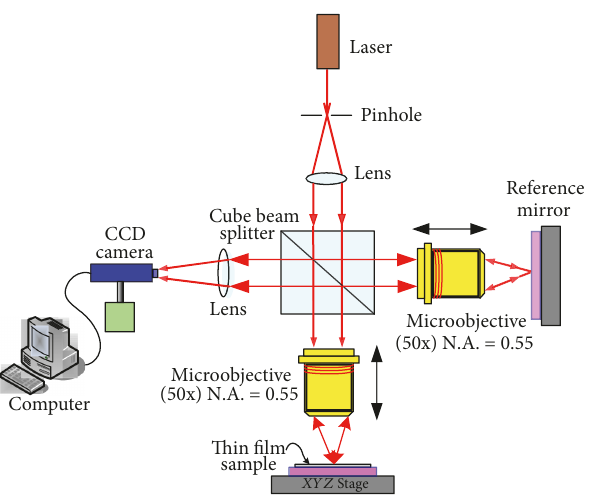
Figure 2: Measurement of surface roughness by using Linnik microscopic interferometer.